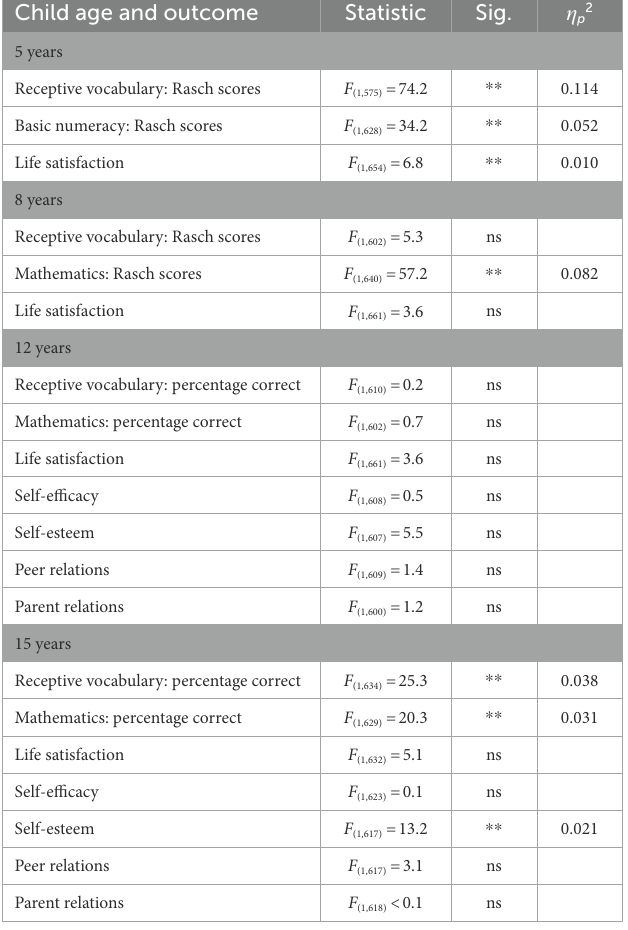
TABLE 9 Summary of analyses comparing outcomes between rural ( n = 373) and urban ( n = 337) Vietnamese children who received a high dose of preschool education. Child age and outcome